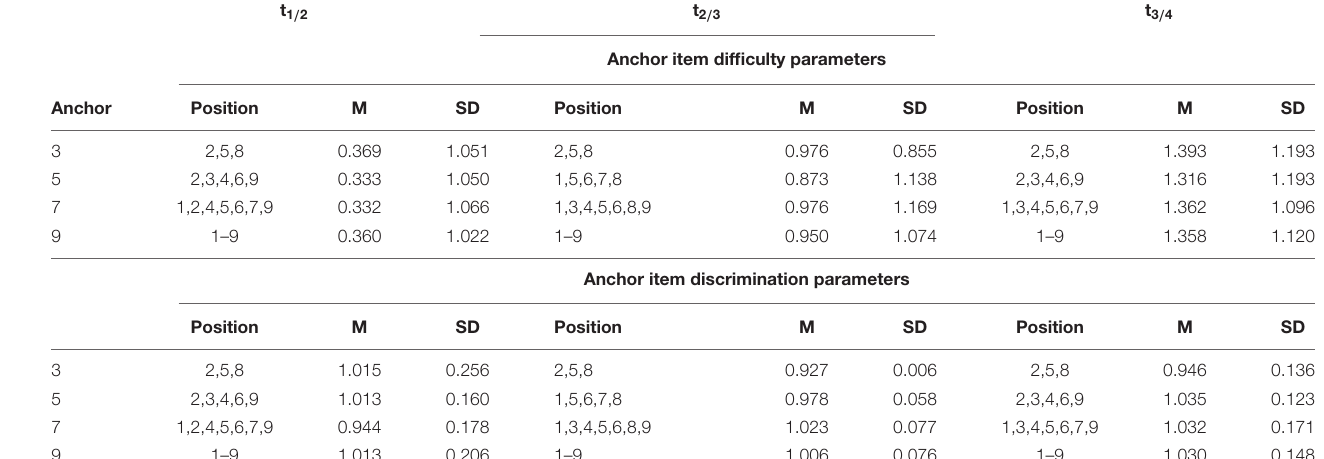
TABLE 2 | Descriptive statistics of the true anchor item parameters split by the experimental factor number of anchor items. t 1 / 2 Anchor item difficulty